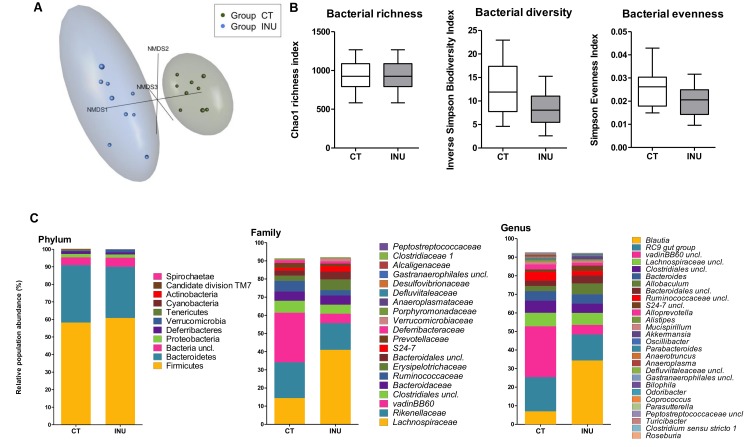
Spatial ordination, bacterial diversity and taxonomical distribution deduced by 16S profiling.Non metric dimensional scaling (three axis) with ellipse showing standard deviation (95% confidence) (A). Bacterial diversity (Inverse Simpson Biodiversity Index), bacterial richness (Chao1 Richness Index) and bacterial evenness (deduced from Simpson Index) (B). Mean Phylotype distribution (Phylum, family and genus levels) expressed as mean cumulated relative abundance (C). Mice were fed fed a control diet (CT, green) or a diet supplemented with 5% inulin (INU, blue) for 27 days.